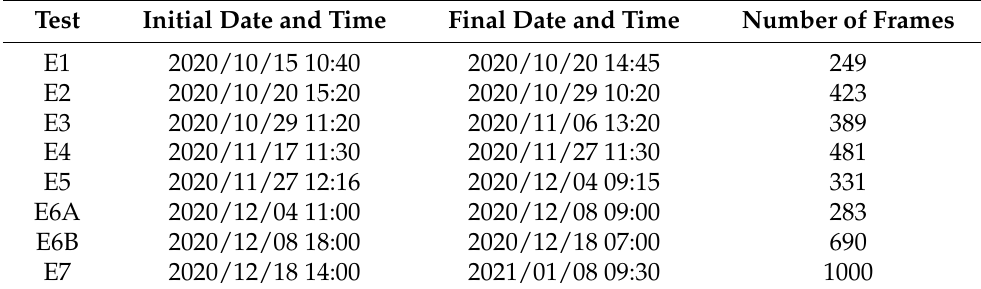
Table 1. Initial and final dates, times, and number of frames for the experimental tests.